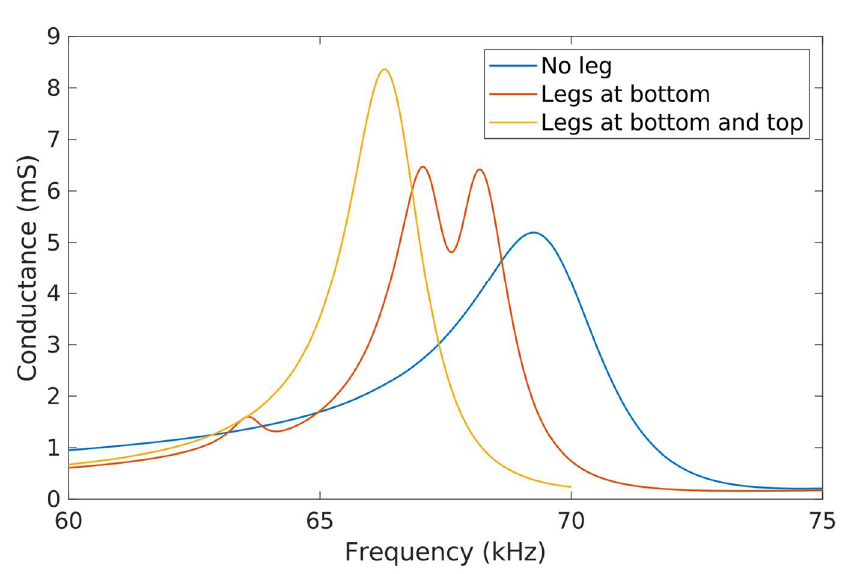
Figure 9. Measured electrical conductance of a PZT plate with no legs (blue), legs at the bottom of the plate (orange) and both the bottom and the top of the plate (yellow).